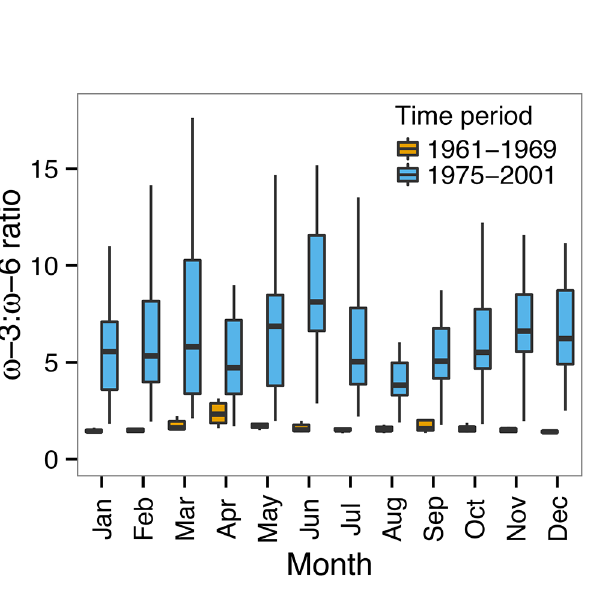
Fig 7. Lake Washington monthly ɷ -3: ɷ -6 fatty acid ratios calculated from phytoplankton biomass from 1961 – 2001. The boxplot colors represent the time periods and boxplot dimensions follow description in Fig 4. The y-axis is set to show the extent of whiskers, excluding extreme outliers with ratio values > 18.